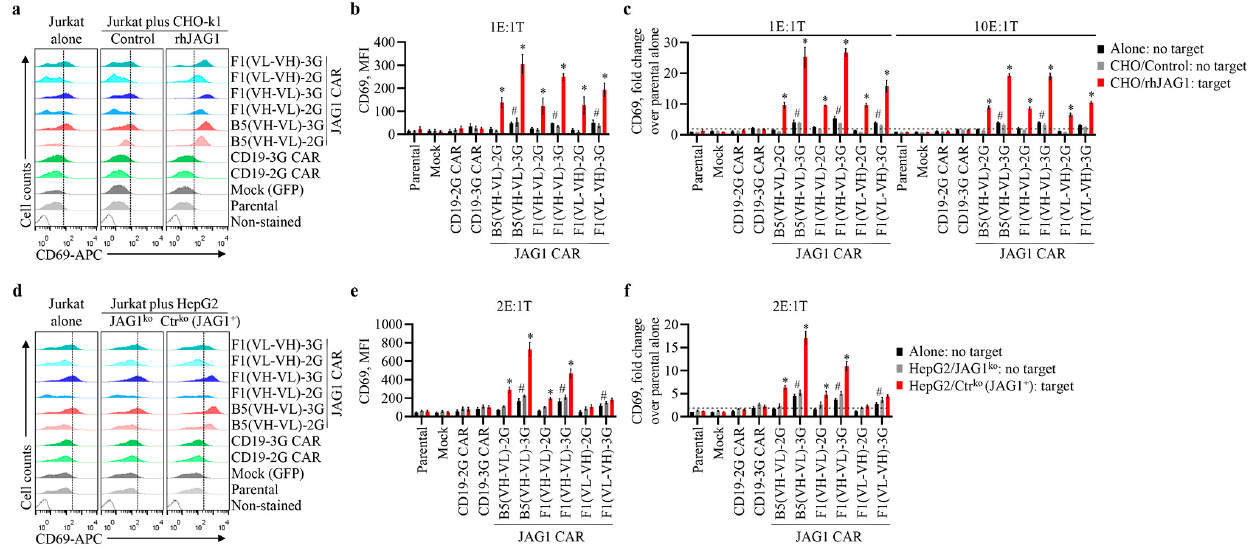
Figure 4. Antigen-specific activation of anti-JAG1 CAR-Jurkat T cells. ( a – f ) Parental Jurkat cells, mock-transduced cells, and zeocin-selected transduced cells anti-JAG1 or control anti-CD19 CARs were cultured alone or with JAG1-negative cells CHO-k1/control or HepG2/JAG1 ko (no-target cells) or the JAG1-positive cells CHO-k1/rhJAG1 or HepG2/Ctr ko (target cells) at the indicated effector to target ratio (E:T). After 21 h, expression of the T-cell activation marker CD69 in Jurkat cells was evaluated via flow cytometry. Mock and CAR-Jurkat cells were gated on GFP signals. ( a , d ) Representative flow cytometry plots of CD69 expression in Jurkat cells’ monocultures or cocultures with the indicated cells using an E:T ratio of 1:1 and 2:1, respectively. Horizontal dashed lines mark CD69 induction threshold relative to control parental cells. ( b , e ) Bar graphs show quantification of CD69 expression (mean ± SEM) of three and four independent experiments performed with CHO- k1 and HepG2 cells, respectively. MIF, mean fluorescence intensity. ( c , f ) Mean fold values (±SEM) of CD69 expression relative to parental Jurkat cells cultured alone at the tested E:T ratios from at least three independent assays. The minimal threshold fold increase (horizontal doted lines in ( c , f )) was set to 2. *, significant difference ( p < 0.05) between the anti-JAG1 CAR-Jurkat cells cocultured with target cells expressing JAG1 and control parental Jurkat cells cultured alone. #, significant difference ( p < 0.05) between the indicated groups cultured alone or cocultured with JAG1-negative cells and parental control cells cultured alone. Data were analyzed using 2-way ANOVA with Tukey´s multiple comparisons test.